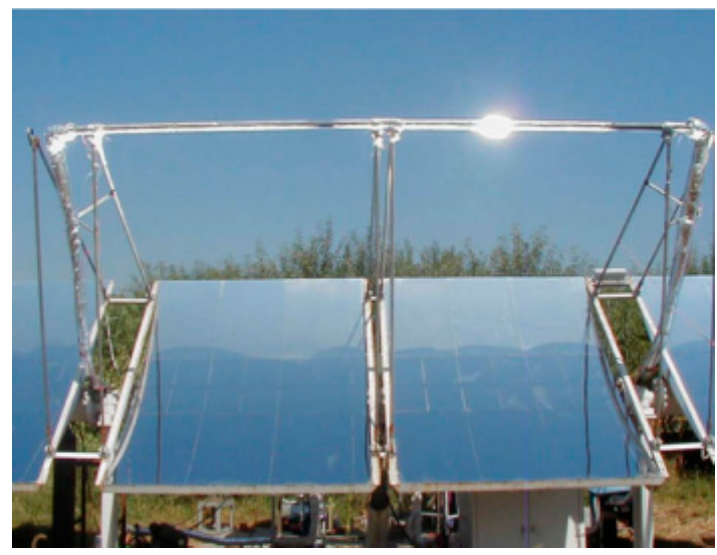
Figure 1. Configuration of the middle and low temperature solar receiver/reactor (MLTSRR).